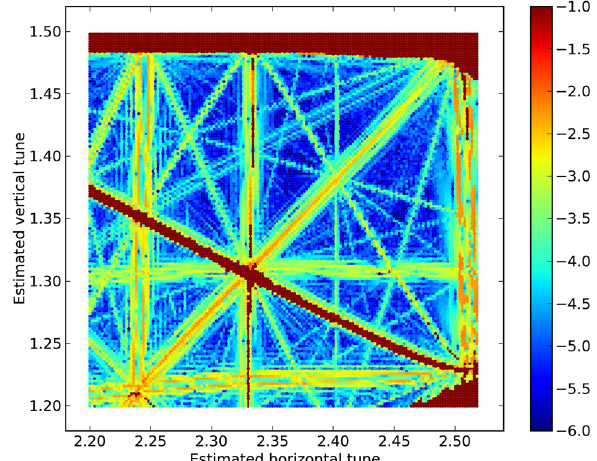
FIG. 4. D plotted as colors against the estimated tunes for the bare ELENA machine, consisting of only the main bendings and the three quadrupole families. The red dots correspond to lost particles.